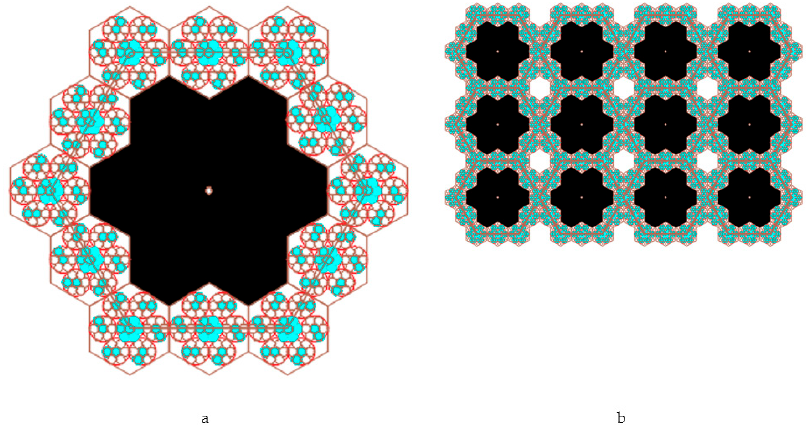
Figure 9. A fragment ( a ) and the enhanced Kepler net of the 4612 type ( b ). Each regular hexagon in the enhanced Kepler net with Schläfli 4612 symbol was filled a quasi-two-dimensional projection of a 3D enhanced non-deterministic Jullien fractal [34] after the second iteration (Figure 10).